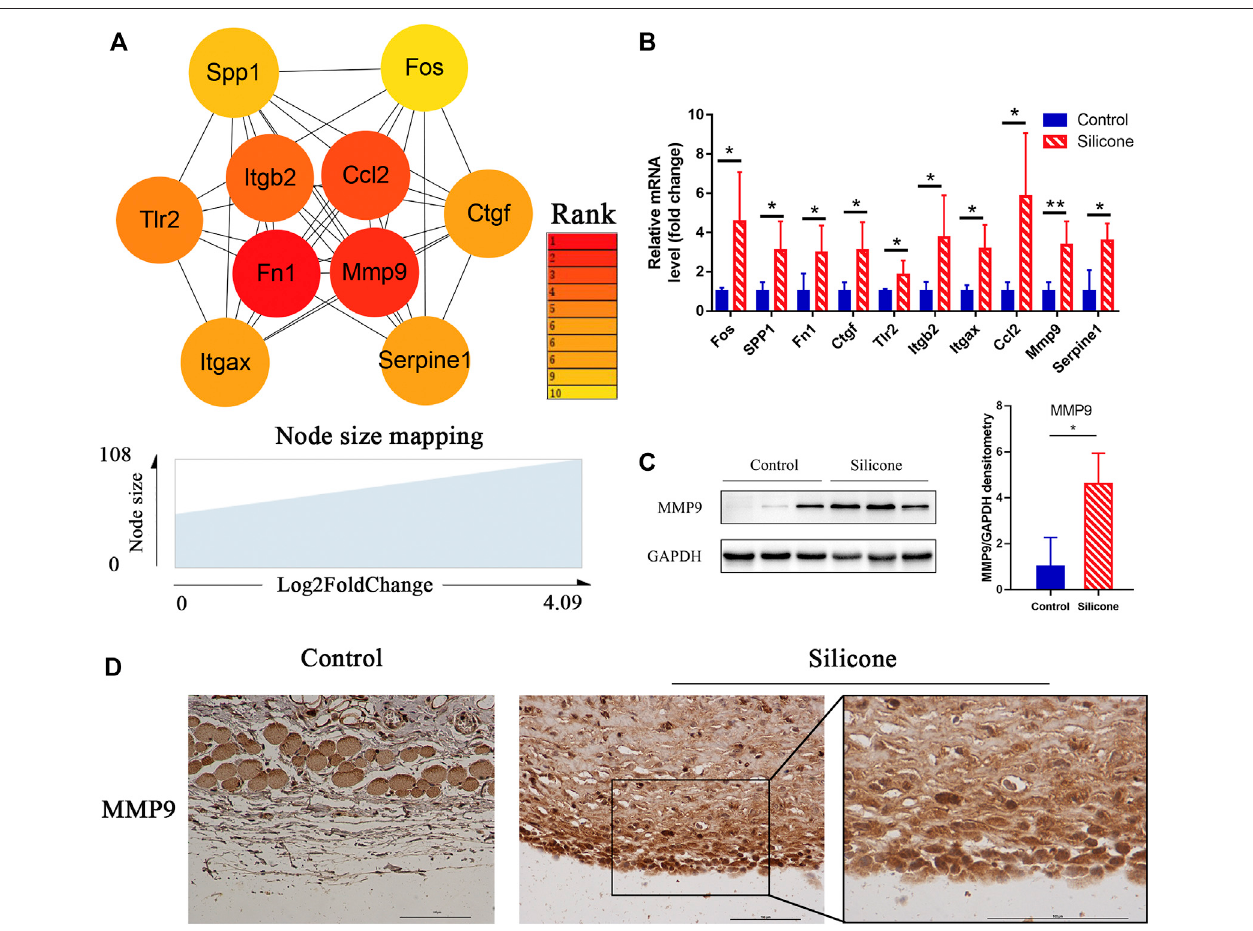
FIGURE 6 | Identi fi cation of hub genes related to the silicone-based FBR and their expression analysis. (A) Hub genes identi fi ed from PPI analysis. (B) The relative mRNA levels of FOS, SPP1, FN1, CTGF, TLR2, ITGB2, ITGAX, CCL2, MMP9, and SERPINE1 using qPCR. (C) Western blot showed a higher level of MMP9 in silicone group than control group. (D) Immunohistochemistry staining showed that MMP9 was mainly located in macrophages and myo fi broblasts. Scale bar = 100 μ m. * p < 0.05, ** p < 0.01.